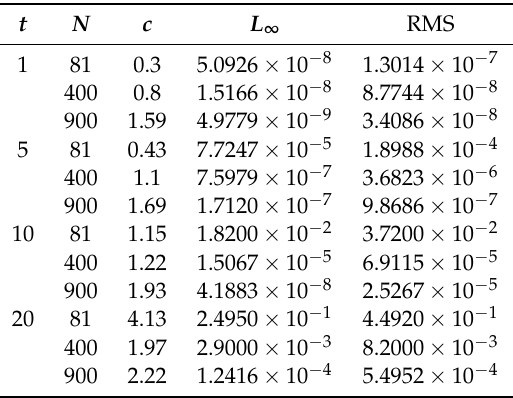
Table 3. Error norms for Problem